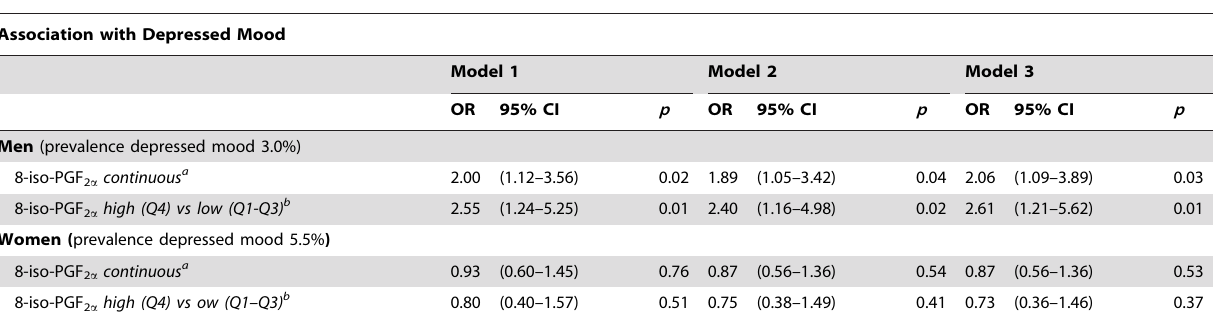
Table 2. Odds ratios (and 95% confidence intervals) of depressed mood according to 8-iso-PGF 2 a concentrations.